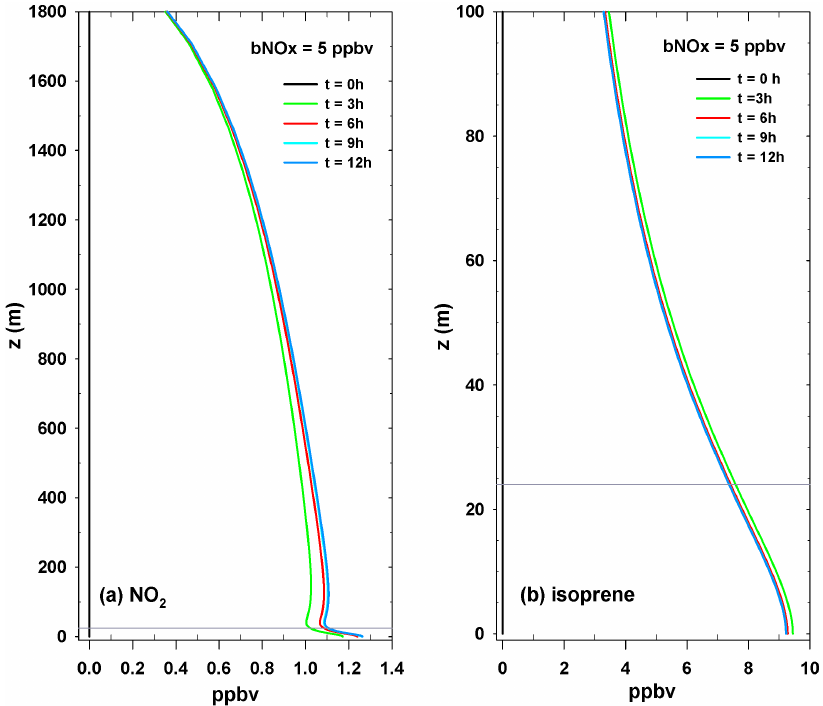
Fig. 5. Vertical profiles of (a) NO 2 and (b) isoprene for bNO x = 5ppbv, illustrating the approach to steady-state over the 12h simulation (horizontal gray line is canopy top height).